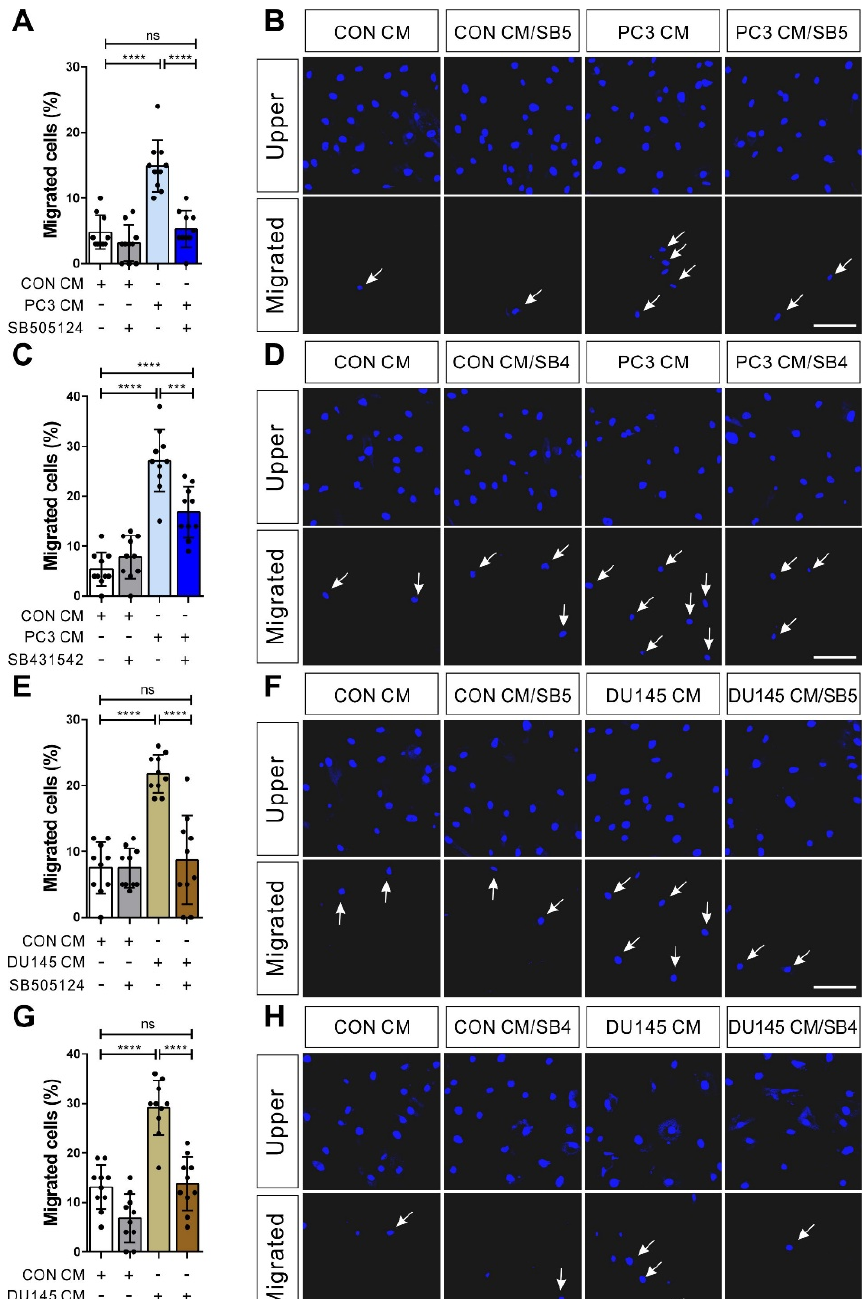
Figure 3. Hormone-insensitive prostate tumor cell-conditioned medium induces the migration of bone marrow-derived mesenchymal stem cells (BM-MSCs) in a TGF- β -dependent manner. ( A – D ) Migration of BM-MSCs pretreated with SB505124 (5 µM; ( A , B )) or SB431542 (10 µM; ( C , D )) for 30 min toward the control-conditioned medium (CON CM) or the PC3-conditioned medium (PC3 CM). ( E – H ) Migration of BM-MSCs pretreated with SB505124 (5 µM; ( E , F )) or SB431542 (10 µM; ( G , H )) for 30 min toward CON CM or the DU145-conditioned medium (DU145 CM). White arrows indicate DAPI-stained nuclei of migrated BM-MSCs on the lower membrane surface. Results are presented as the mean ± SD ( n = 2 samples for each group). Scale bars indicate 100 µm. p -Value were obtained by t -test (*** p ≤ 0.001; **** p ≤ 0.0001; ns, p > 0.05).